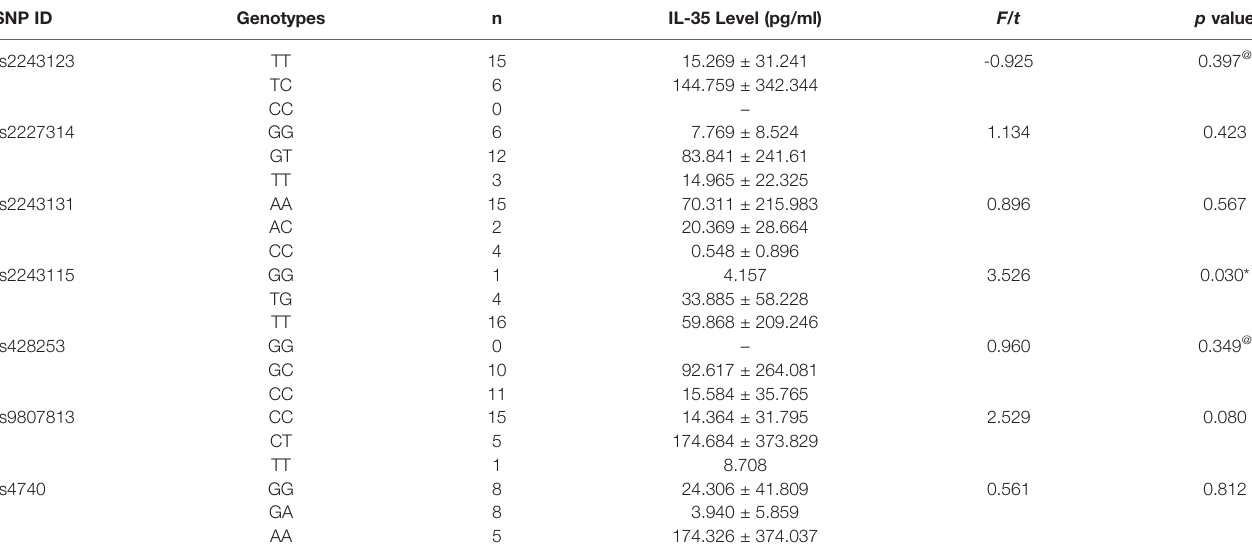
TABLE 8 | Associations of serum IL-35 levels with IL-35 genotypes in VKH